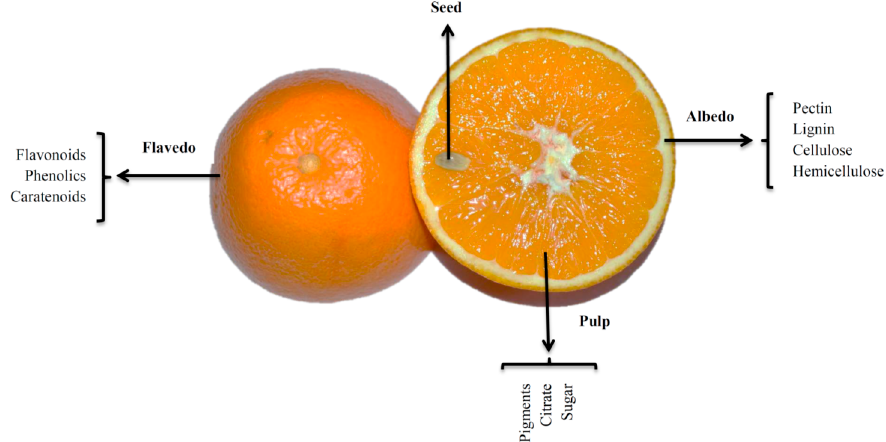
Figure 1. Anatomy of a citrus fruit.